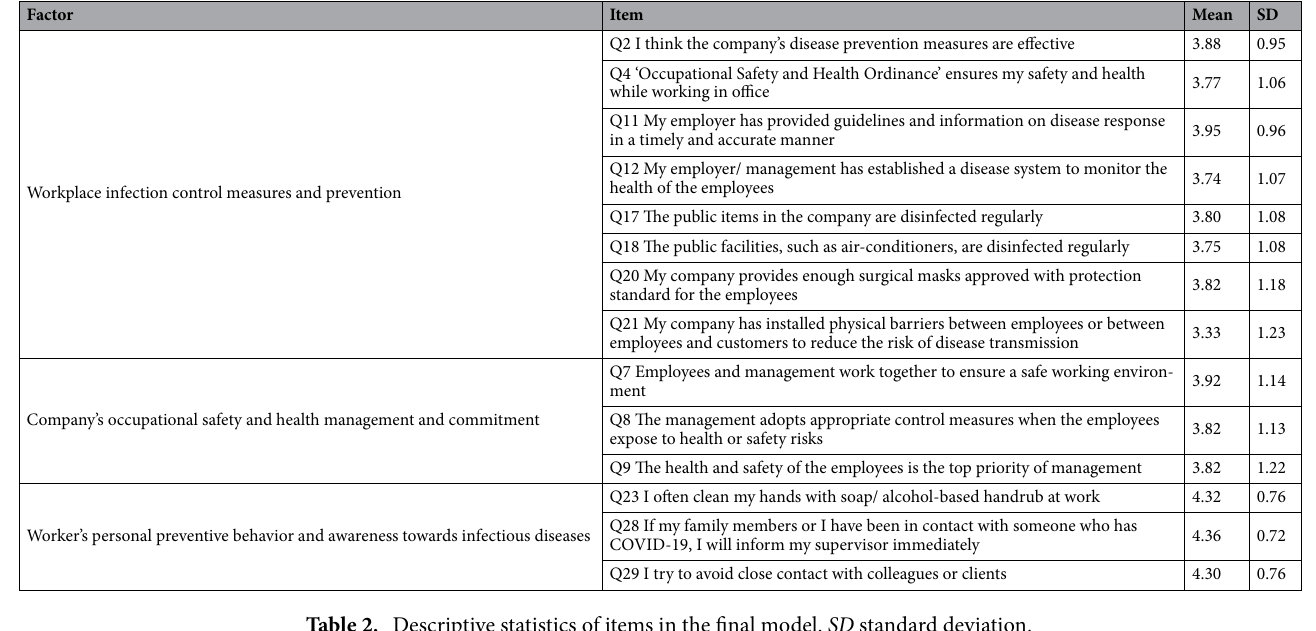
Table 2. Descriptive statistics of items in the final model. SD standard deviation.